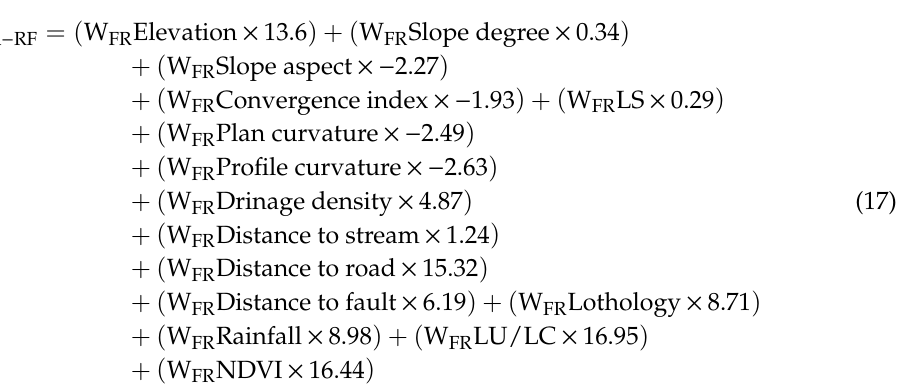
Table 5. Confusion matrix from random forest (RF) model (0 = non ‐ landslide or negative, 1 = landslide or positive).